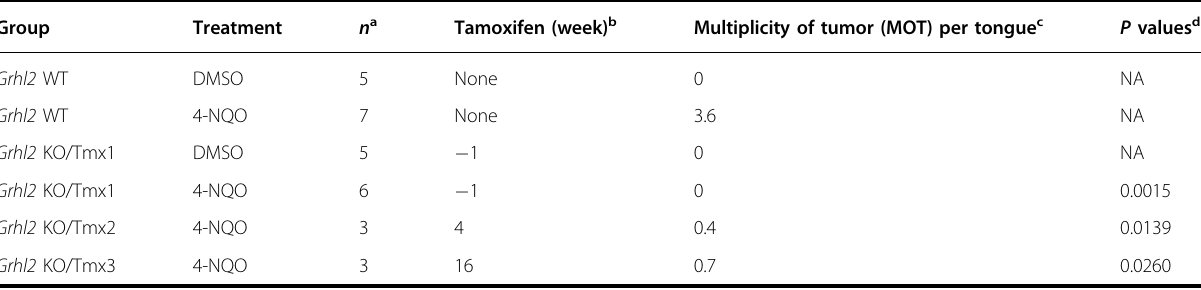
Table 1 Tumor nodule formation on tongue epithelium in mice exposed to 4-NQO